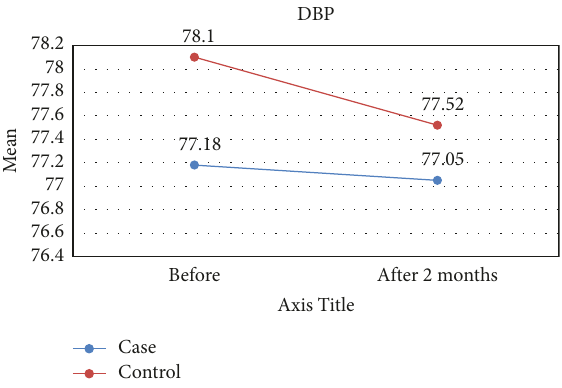
Figure 8: Effect of lycopene supplementation on DBP